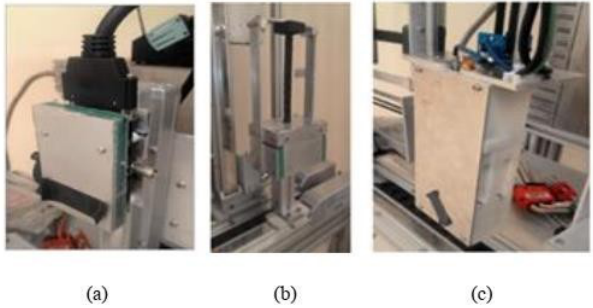
Fig. 7. From left to right, (a) the shielded TimePix3 pixel detector, (b) one shielded fiber scintillator, and (c) the shielded diamond detector can be seen. Numerous designs were studied for these detectors and the best results were chosen for each.